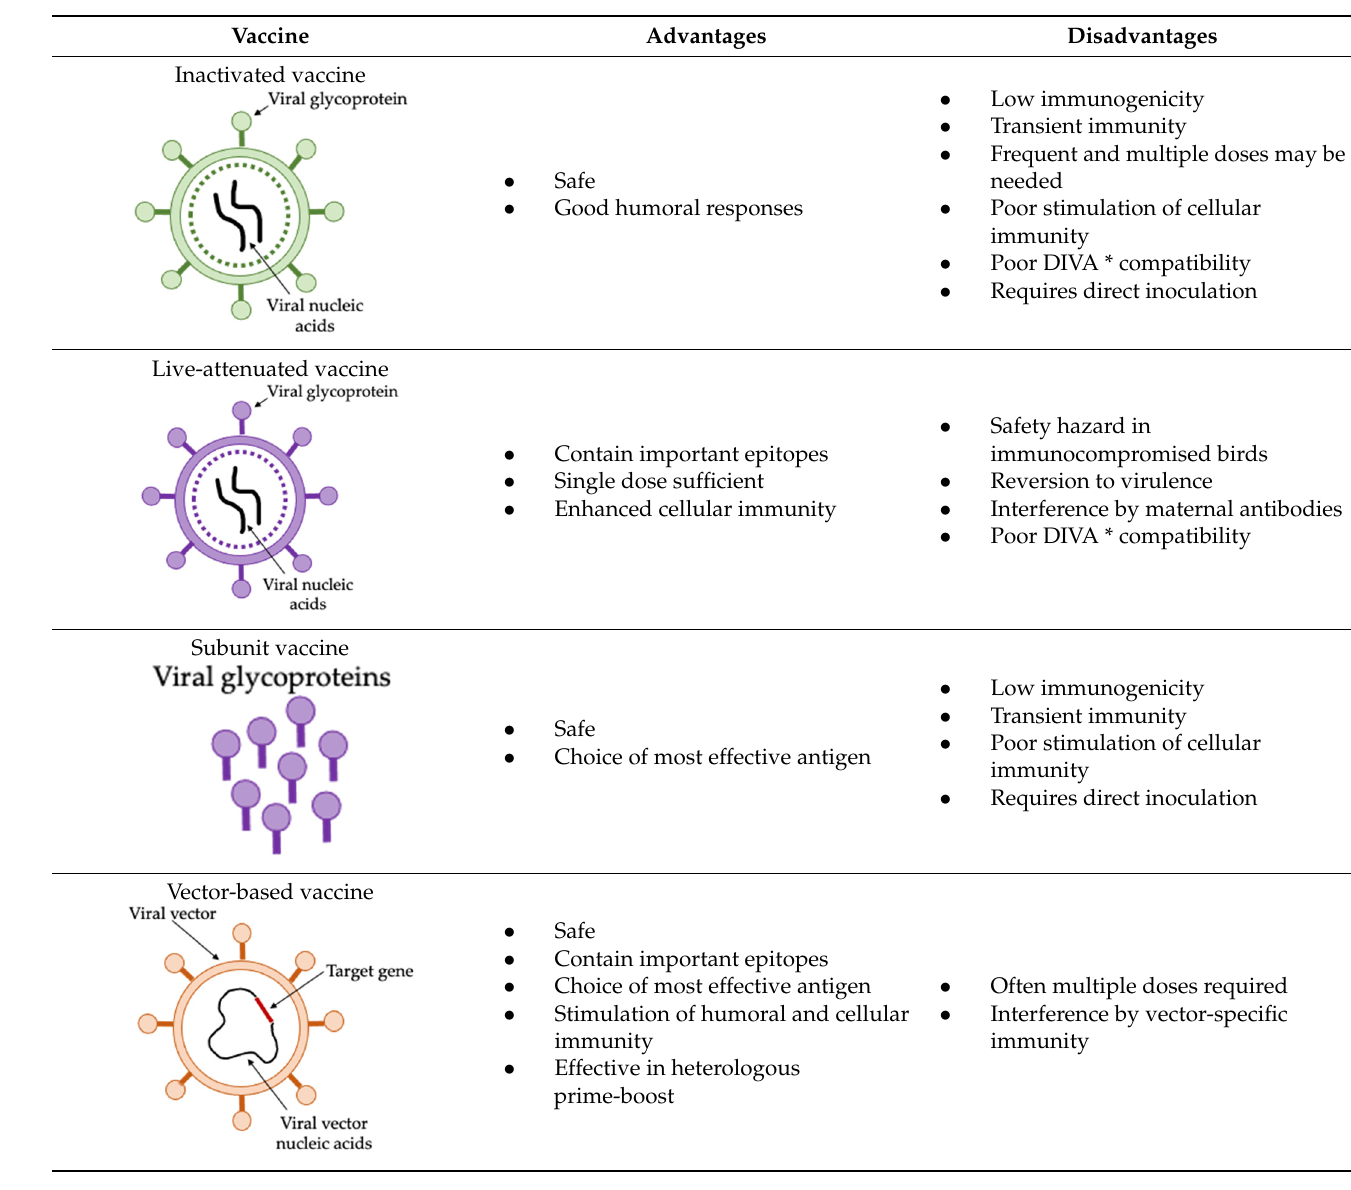
Table 1. Common types of vaccine and their respective advantages and disadvantages; modified from [24].